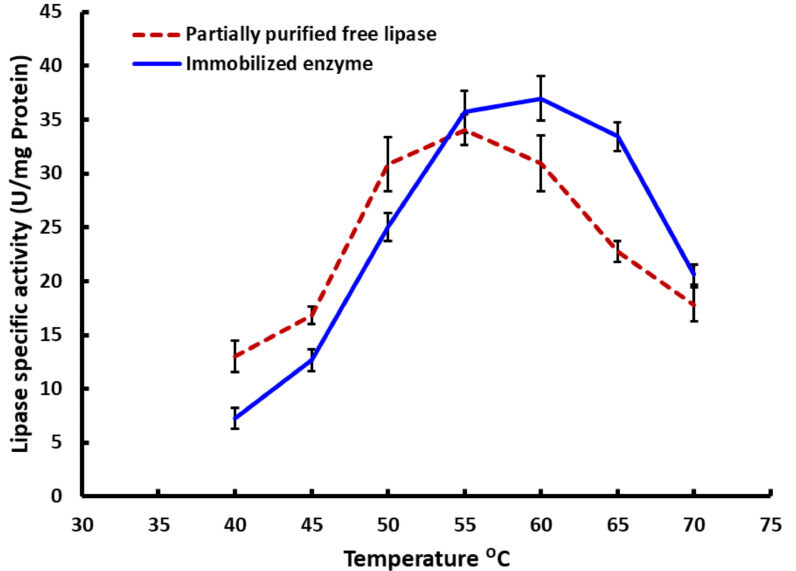
Figure 3. Effect of the reaction mixture temperature on the partially purified free enzyme and immobi- lized lipase-specific activities. The means value of three replicates ± SD (vertical bars) is represented.